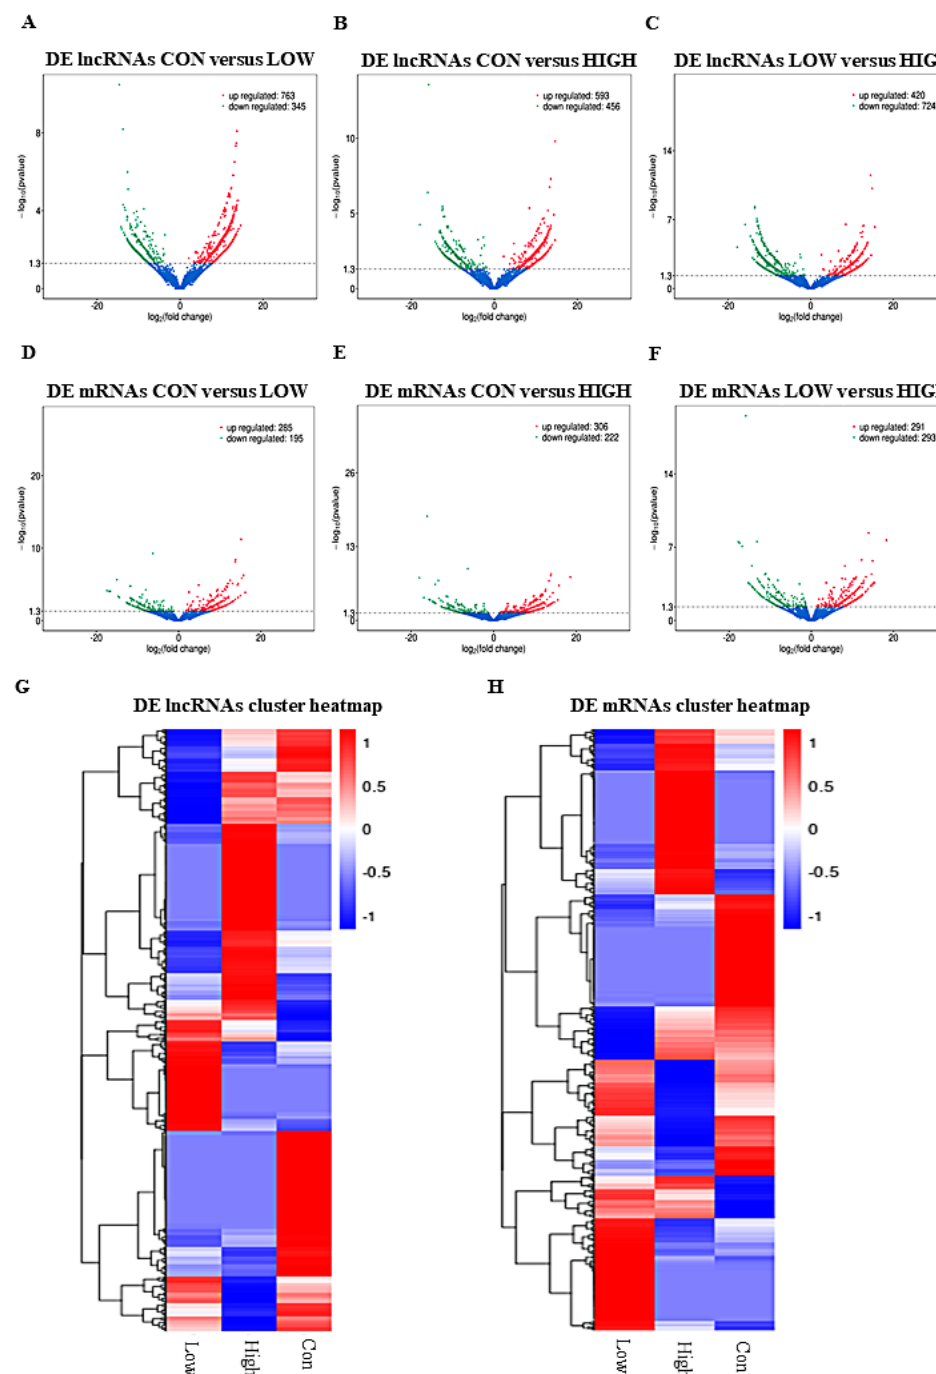
Figure 3. The expression profiling changes of lncRNAs and mRNAs in GCs. ( A – C ) Volcano plot indicating up − and downregulated lncRNAs of ovary GCs in different glucose treatment groups (CON versus LOW, CON versus HIGH and LOW versus HIGH); up − and downregulated genes are colored in red and green, respectively. ( D – F ) Volcano plot indicating up − and downregulated mRNAs of ovary GCs in different glucose treatment groups (CON versus LOW, CON versus HIGH and LOW versus HIGH); up − and downregulated genes are colored in red and green, respectively. ( G , H ) Heatmap of lncRNAs ( G ) and mRNAs ( H ) showing hierarchical clustering of changed lncRNAs and mRNAs of GCs in different glucose treatment groups; up − and downregulated genes are colored in red and blue, respectively.